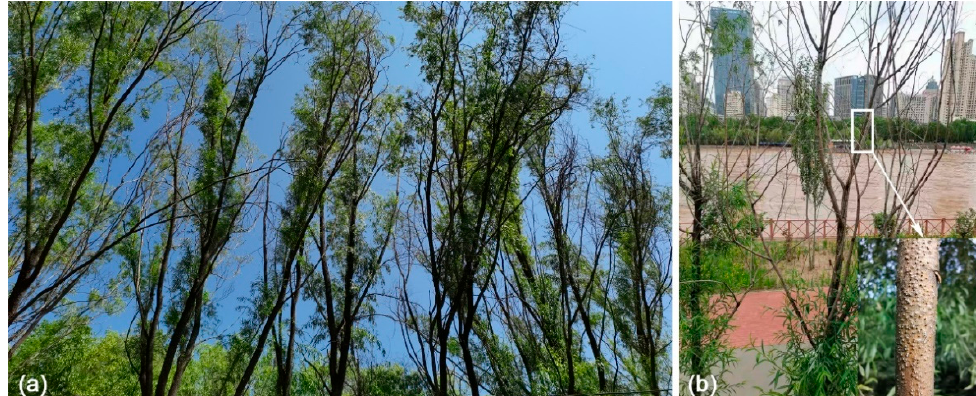
Figure 1. Field sampling in Lanzhou City, Gansu Province: ( a ) death of the willow trees caused by Cytospora species; ( b ) symptoms of branches canker.